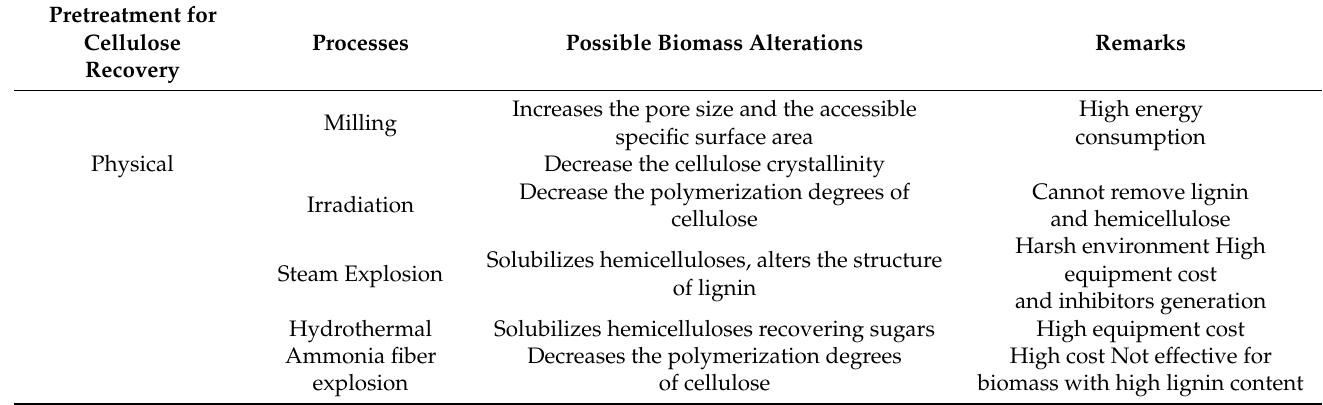
Table 1. Pretreatment methods for lignocellulosic